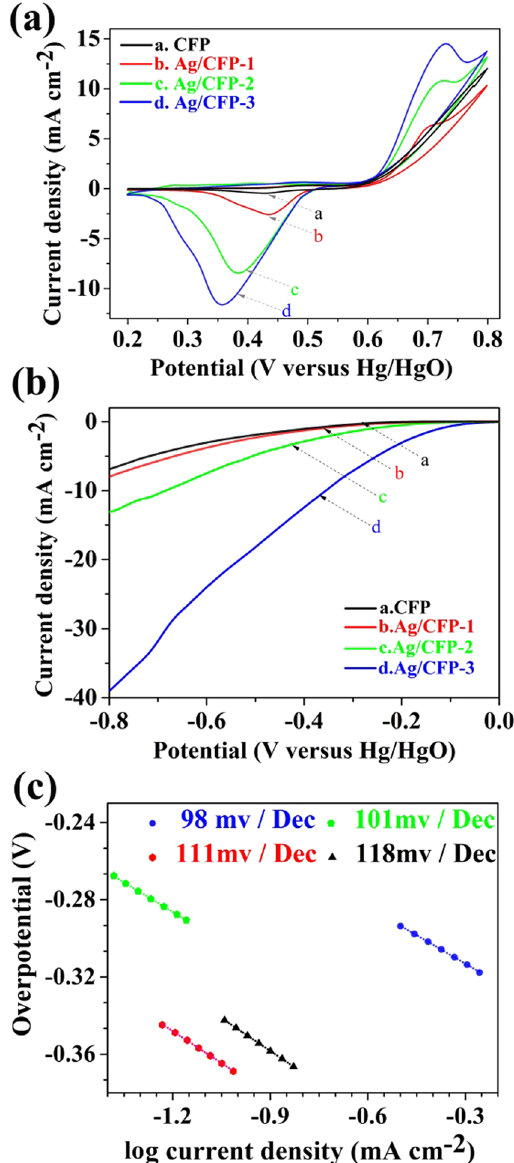
Figure 5. ( a ) Cyclic voltammograms, ( b ) linear sweep voltammograms and ( c ) Tafel plots of CFP (black line), Ag/CFP-1 (red line), Ag/CFP-2 (green line) and Ag/CFP-3 (blue line), in O 2 -purged 0.1 M NaOH solution.